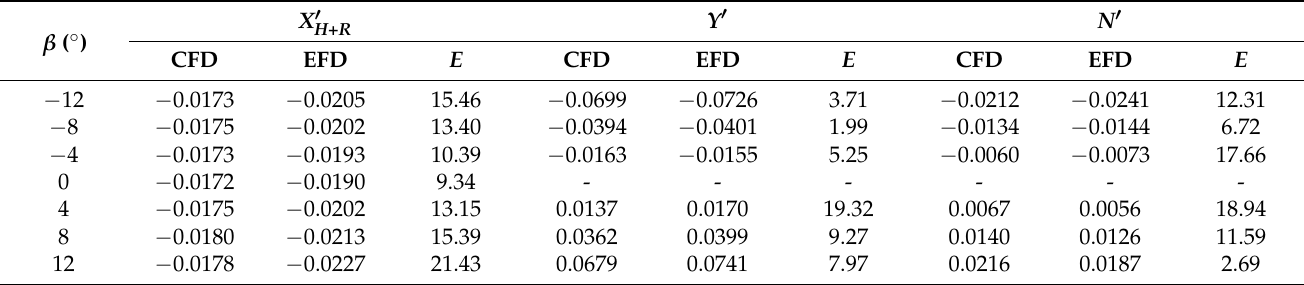
Table 12. The error between the CFD computed results and EFD data for double-body flow simulation, Fr = 0.201.